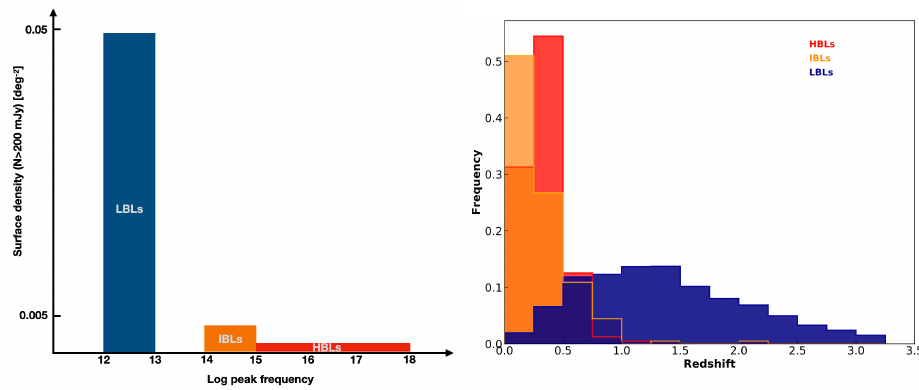
Figure 1. The surface density ( left side ) and redshift distributions ( right side ) of LBL, IBL and HBL blazars with radio flux density larger than 200